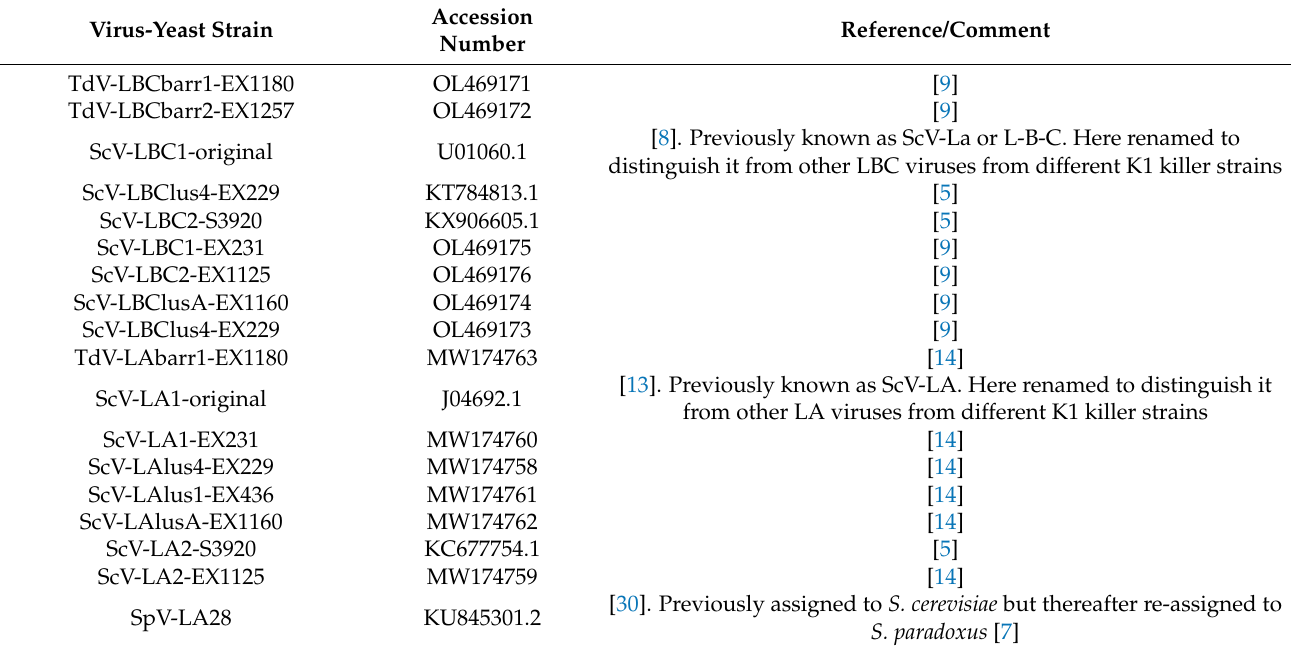
Table 2. Nucleotide sequence of yeast LBC and LA virus genomes used in this